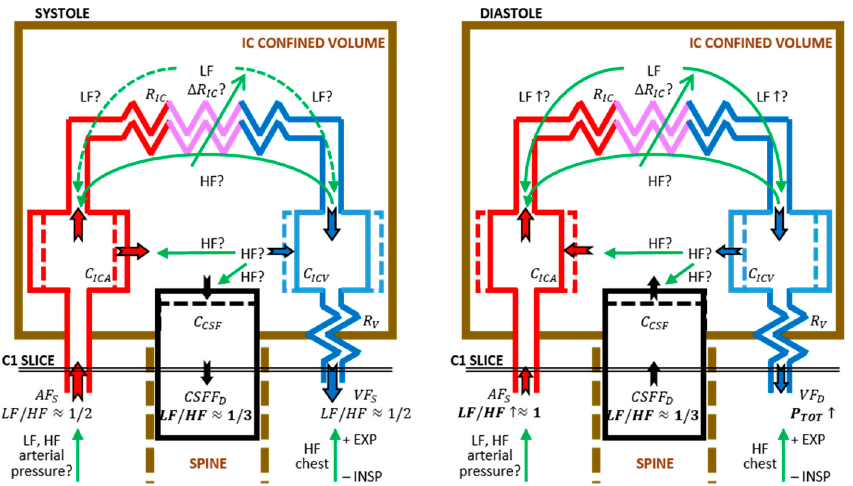
Figure 5. Schematic representation of systolic ( left panel ) and diastolic ( right panel ) flows, measured at C1 cervical level. AF is shown in red, VF is shown in blue, and CCSF is shown in black. The arrow dimension provides a qualitative sketch of flow rate order of magnitude. Flows are represented as hypothetically split into resistive and capacitive coupling flows. As to BBV, LF, and HF components, the main findings are reported in bold. Hypotheses about sources and propagation of LF and HF waves are indicated by the green arrows and labeled by question marks. Legend of symbols not in the text: R IC and ∆ R IC , peripheral IC resistances and their modulations; C ICA and C ICV , IC arterial and venous compliances, respectively; C CSF , IC CSF compliance, coupled to the spinal CSF